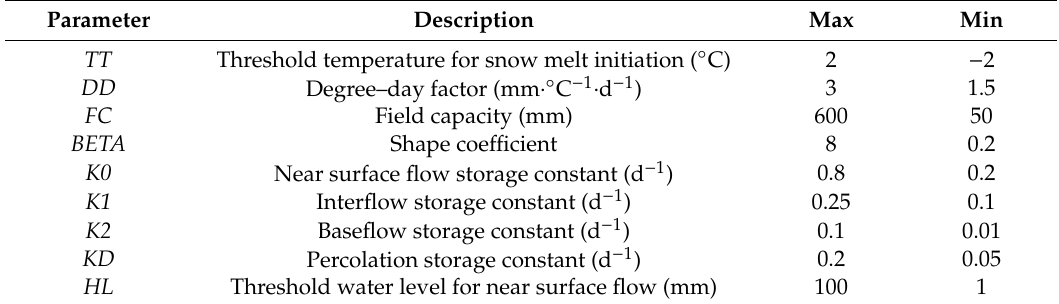
Table 3. Description and initial range of the HBV model